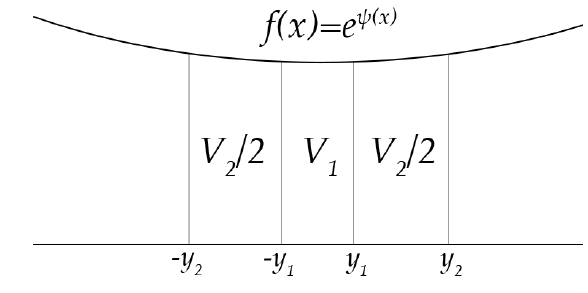
Figure 7: A triple interval on the real line.